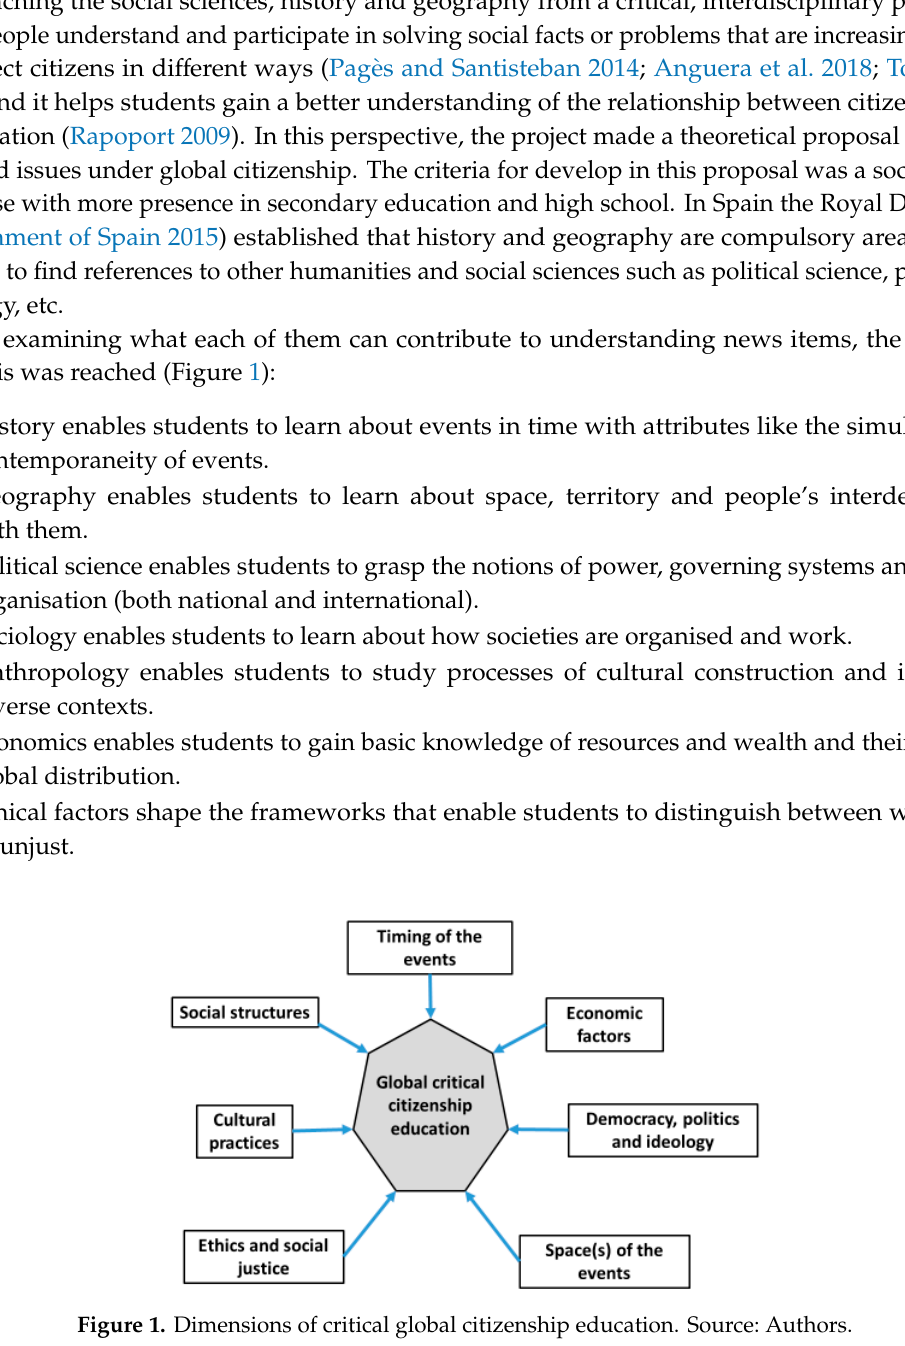
Figure 1. Dimensions of critical global citizenship education. Source: Authors.